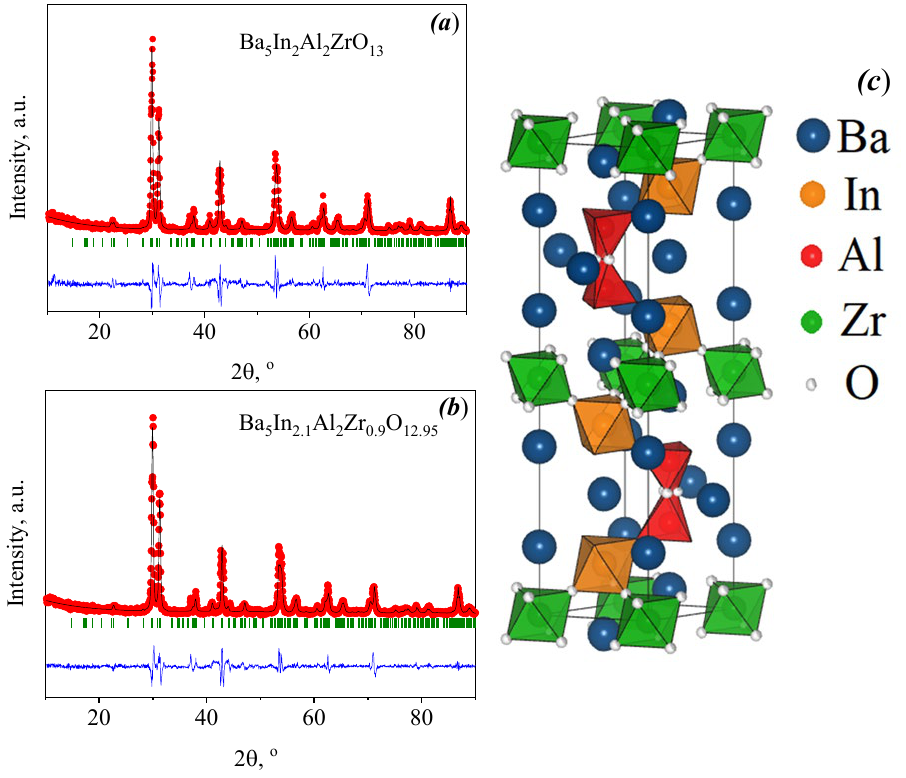
Figure 2. Rietveld profile fitting of powder X-ray diffraction pattern for Ba 5 In 2 Al 2 ZrO 13 ( a ) and Ba 5 In 2.1 Al 2 Zr 0.9 O 12.95 ( b ); observed (dots), calculated (line), difference (bottom) data, and angular positions of reflections (bars) are shown. The crystal structure of Ba 5 In 2 Al 2 ZrO 13 ( c ).